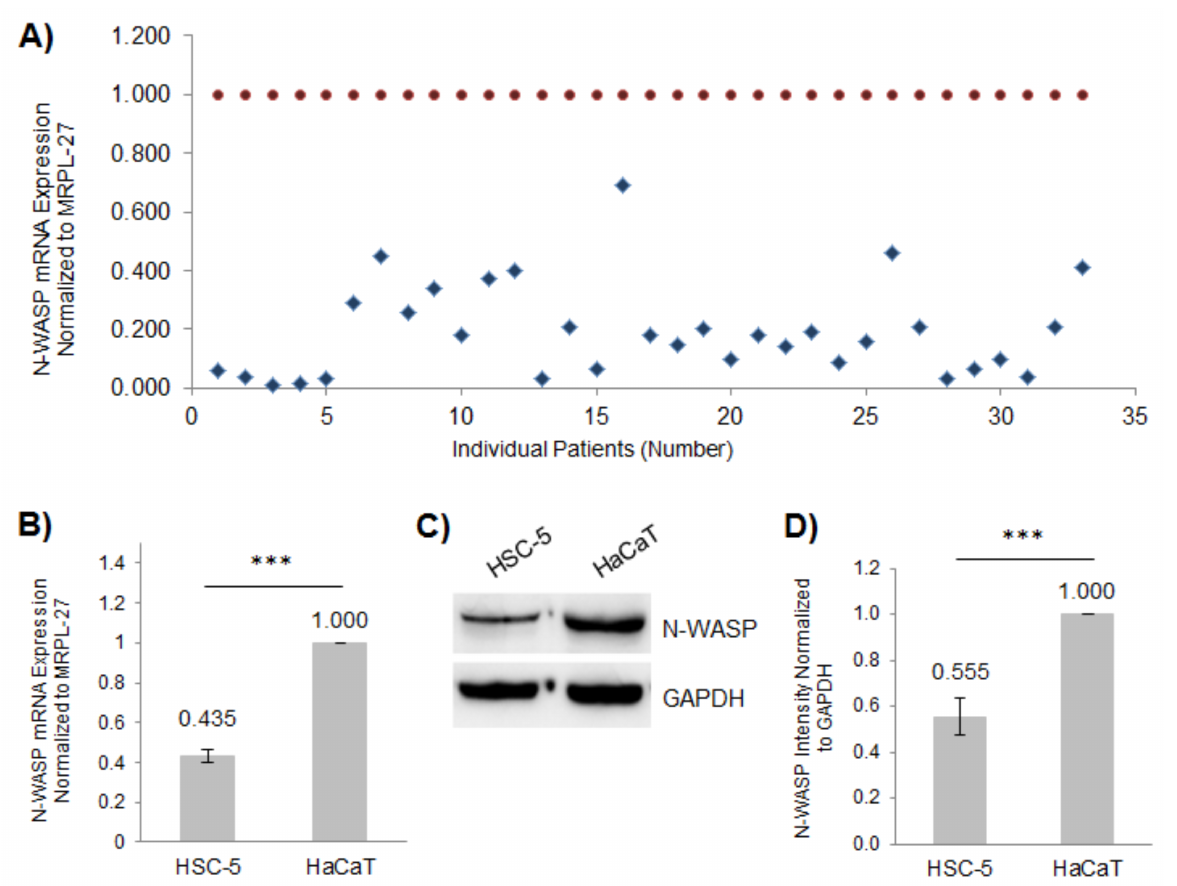
Figure 1. Expression of N-WASP is reduced in SCC patient samples and the SCC cell line HSC-5. ( A ) The total RNA was extracted from the paraffin-embedded SCC and matched perilesional samples and reverse-transcribed to cDNA for quantifying the N-WASP expression relative to MRPL-27 using real-time PCR, normalized to individually matched perilesional samples (SCC values: blue diamonds, matched perilesional values: red circles); n = 33. ( B ) The total RNA was extracted from the HSC-5 and HaCaT cells and reverse transcribed to cDNA for quantifying N-WASP expression relative to MRPL-27 using real-time PCR, normalized to HaCaT cells. ( C ) Representative Western blots of N-WASP and GAPDH (loading control) in the HSC-5 and HaCaT cells; n = 3. ( D ) Densitometric quantification of the N-WASP/GAPDH ratio in HSC-5 cells normalized to HaCaT cells. All values are the mean ± SD, n = 3, *** p <